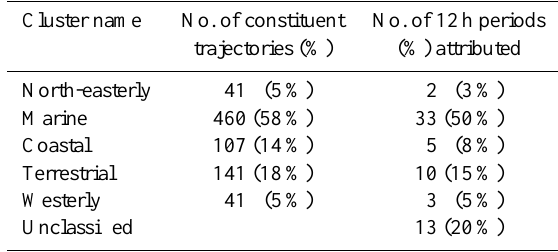
50 Table 2. Details of five cluster solution and resultant period classi- fication for